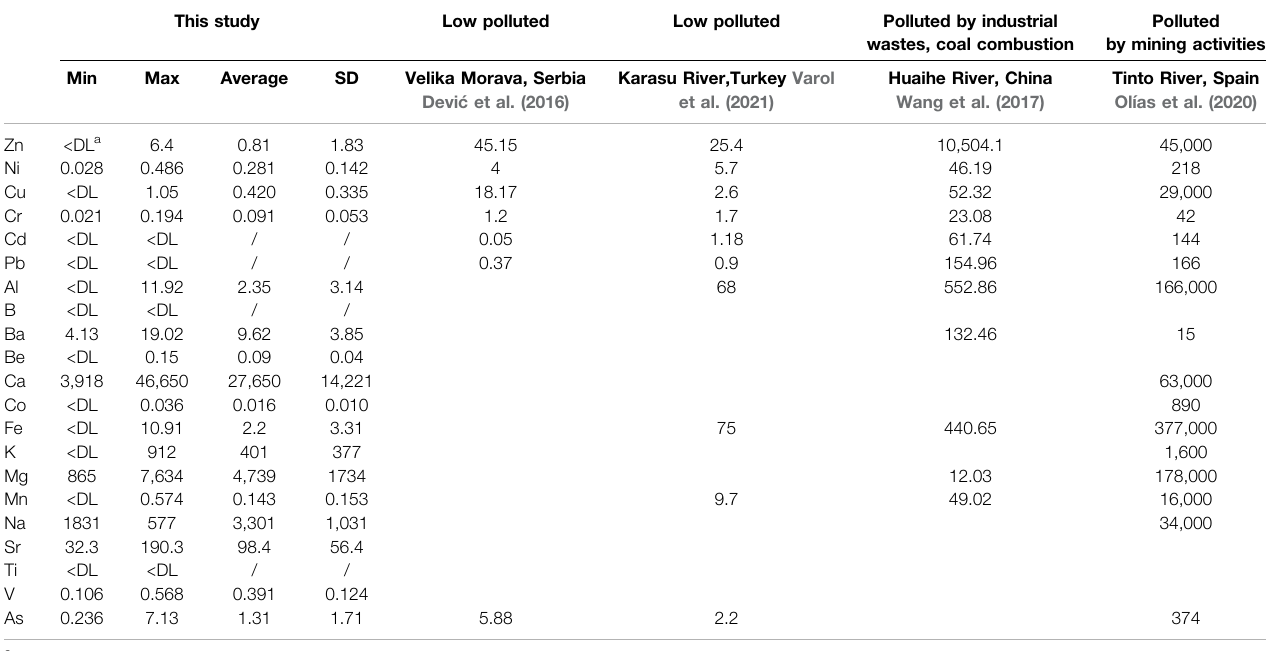
TABLE 3 | Descriptive statistics for studied elements ( μ g/L) and comparison with other rivers.